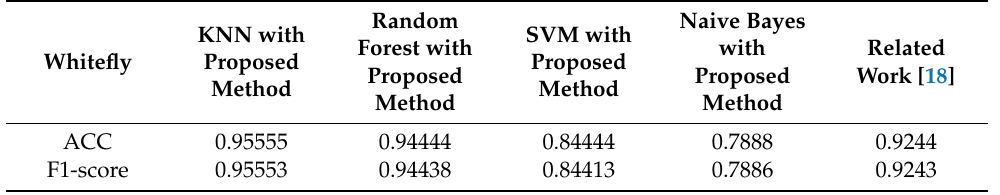
Figure 10. Transfer learning from historical data to real-time data in Experiment 2. Table 8. Results for prediction of the numbers of whitefly pests.